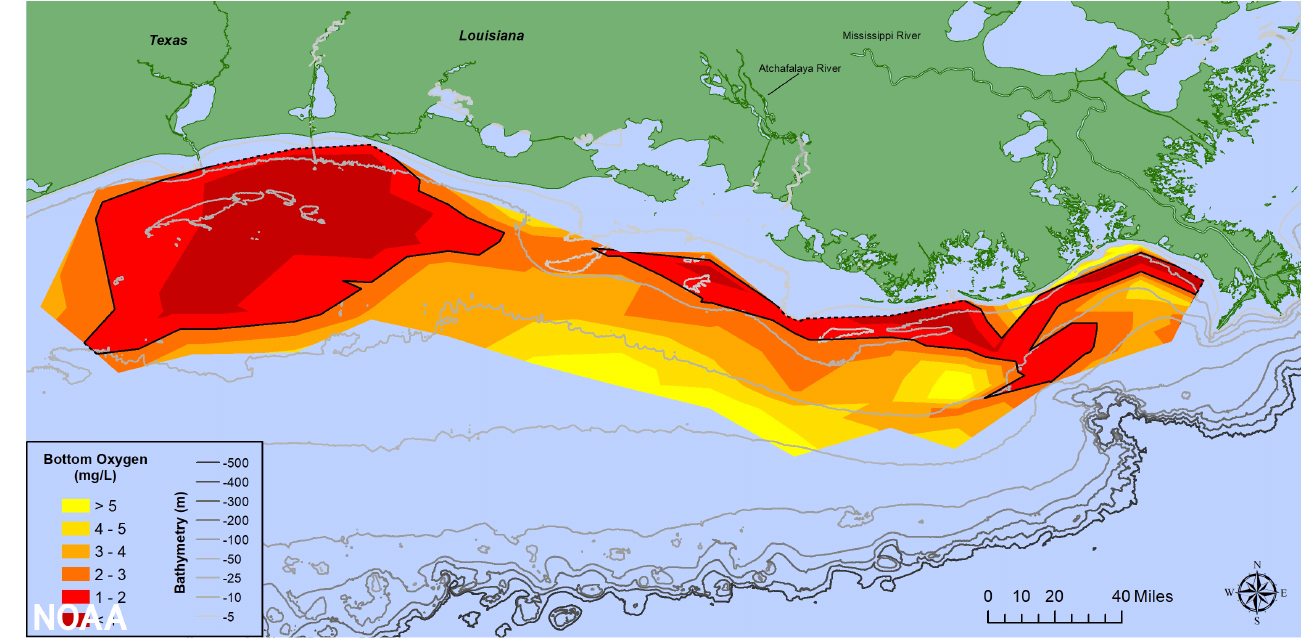
Figure 3. Map of measured Gulf hypoxia zone, 25–31 July 2021. (LUMCON/NOAA).